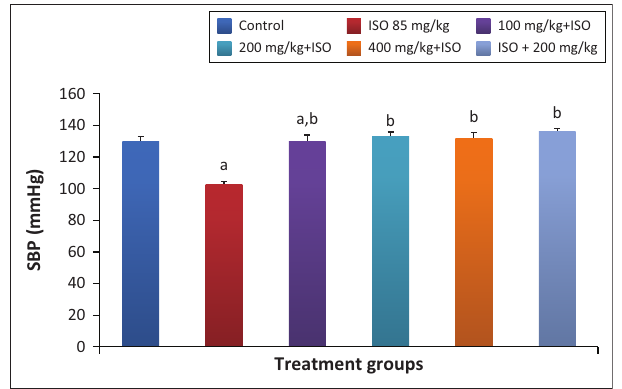
FIGURE 1: Effect of the ethanolic leaf extract of Andrographis paniculata on systolic blood pressure (SBP) in isoproterenol-induced myocardial infarction in